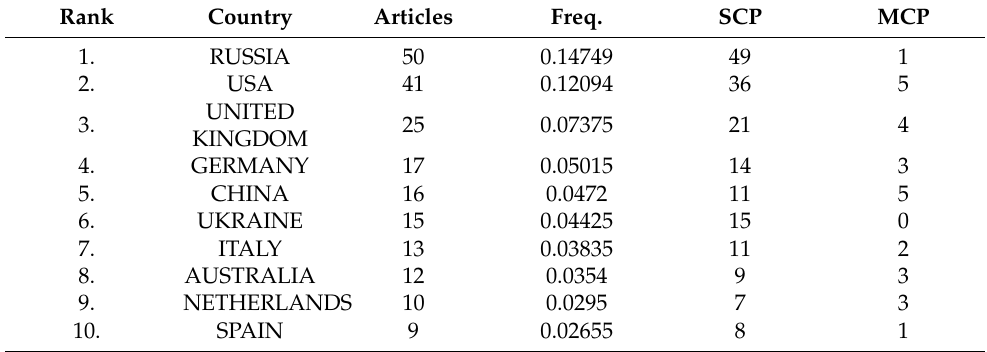
Table 8. The intra-country (SCP) and inter-country (MCP) collaboration indices during 2015–2019.